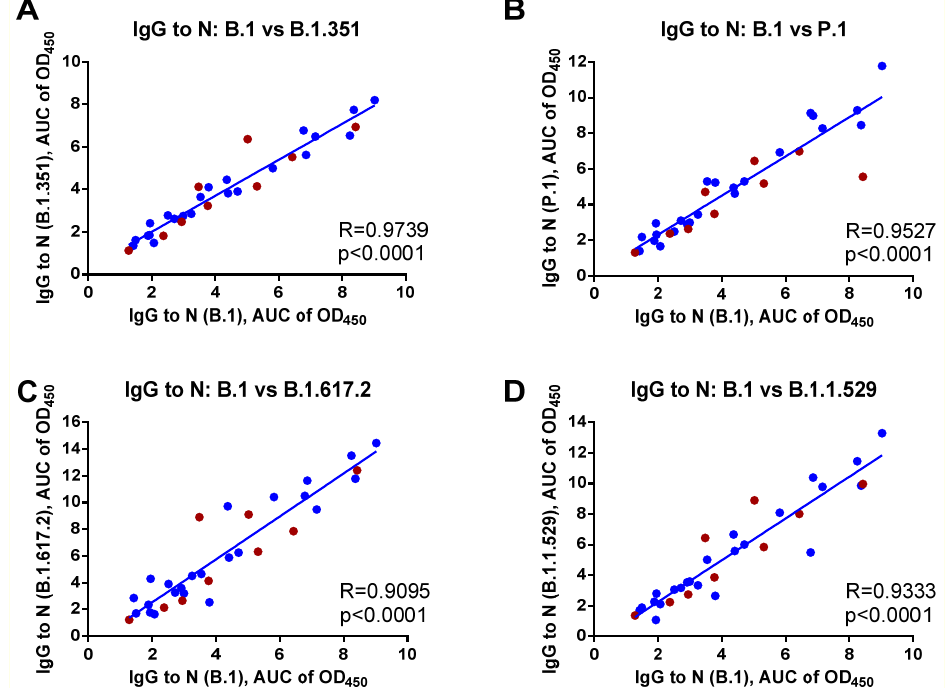
Figure 4. Correlation analyses of N-specific IgG antibody levels in COVID-19 convalescents between the N protein of B.1 (Wuhan) strain and ( A ) B.1.351 (Beta); ( B ) P.1 (Gamma); ( C ) B.1.617.2 (Delta); and ( D ) B.1.1.529 (Omicron) variants. Sera from patients who recovered from B.1 (blue dots) and B.1.617.2 (dark red dots) variants were analyzed ( n =